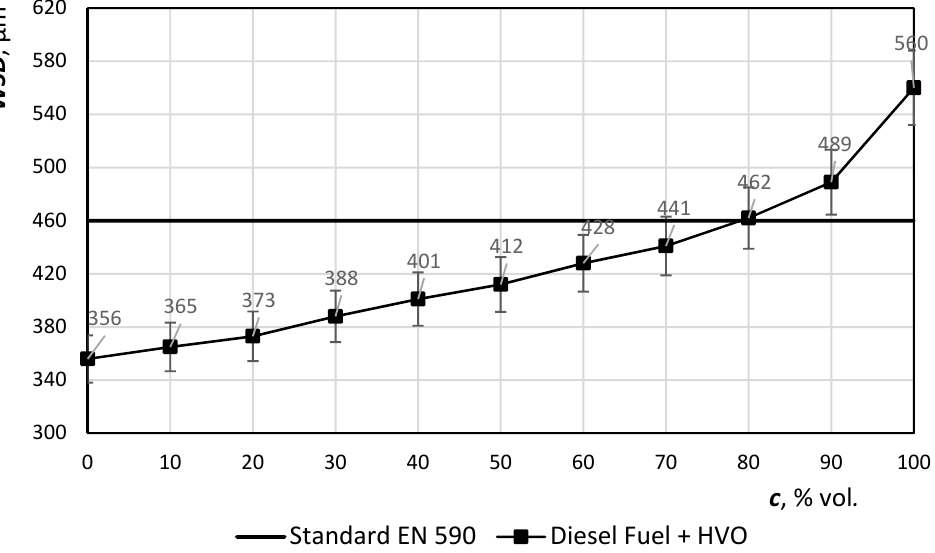
Figure 6. Lubricity of diesel fuel with addition of HVO.